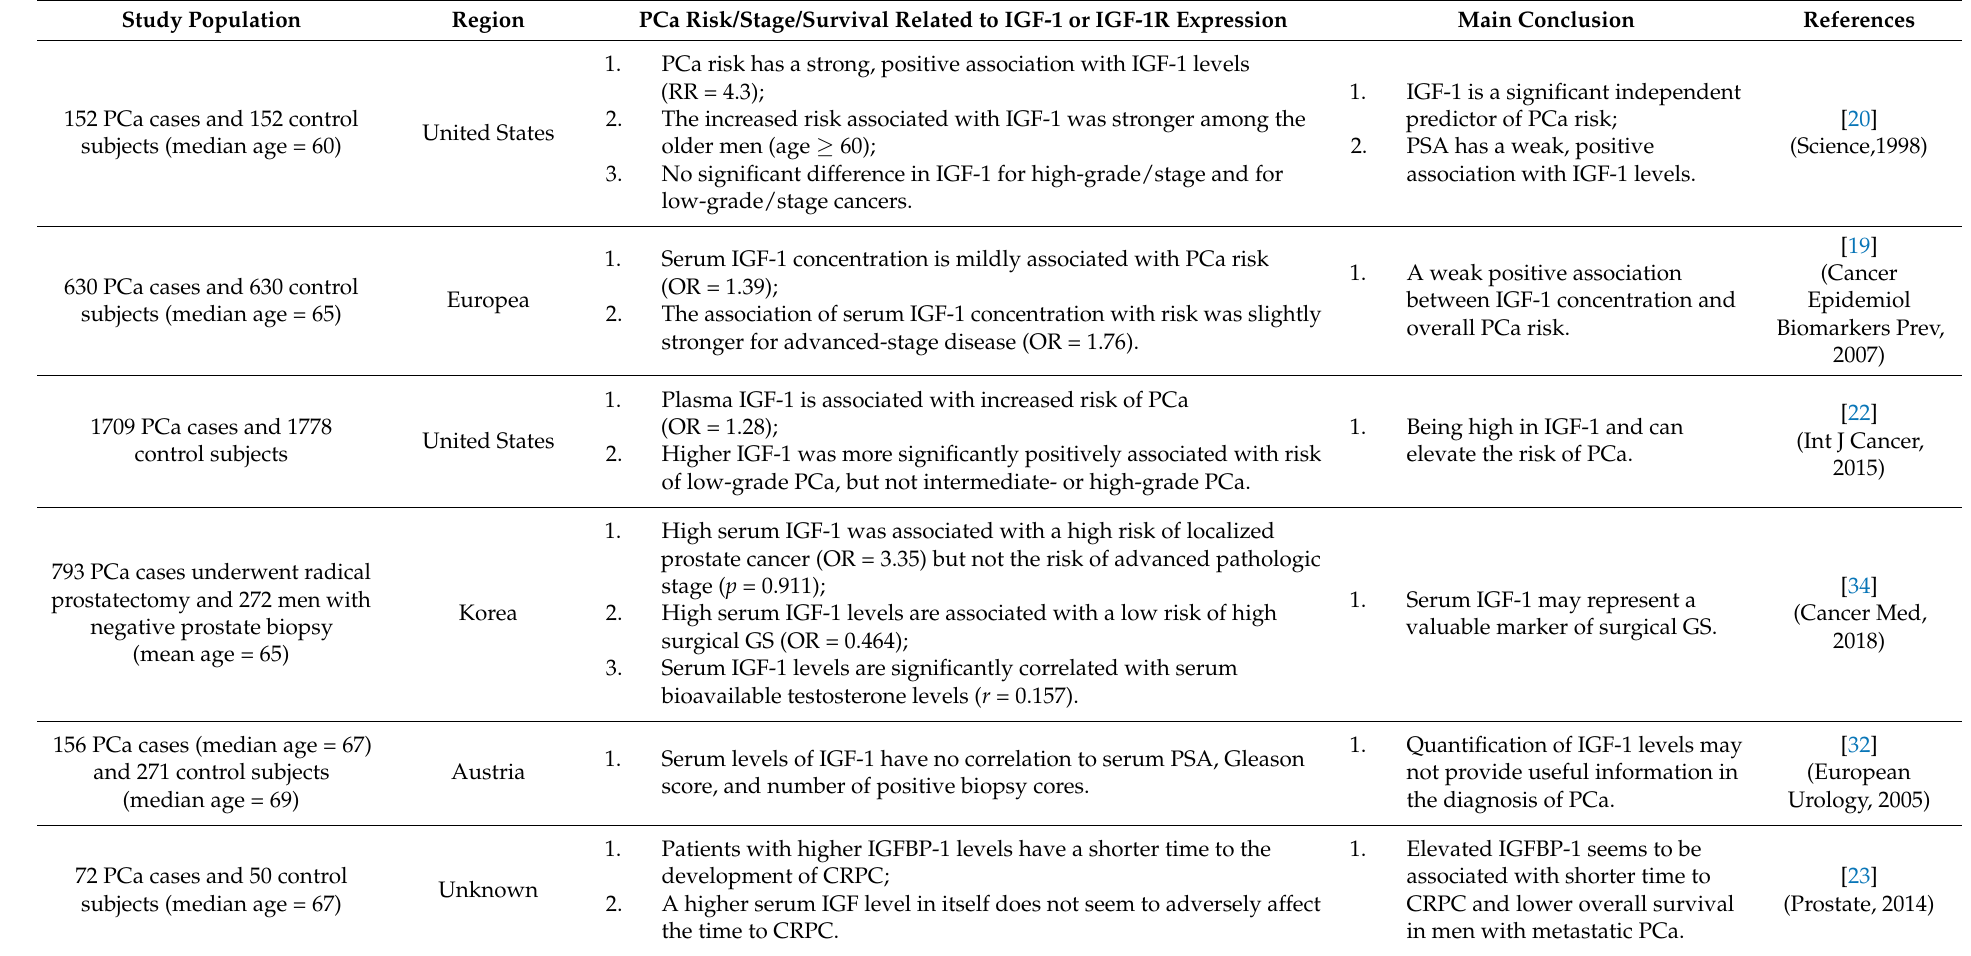
Table 1. Population case-control analysis of serum IGF-1 and local IGF-1R expression in